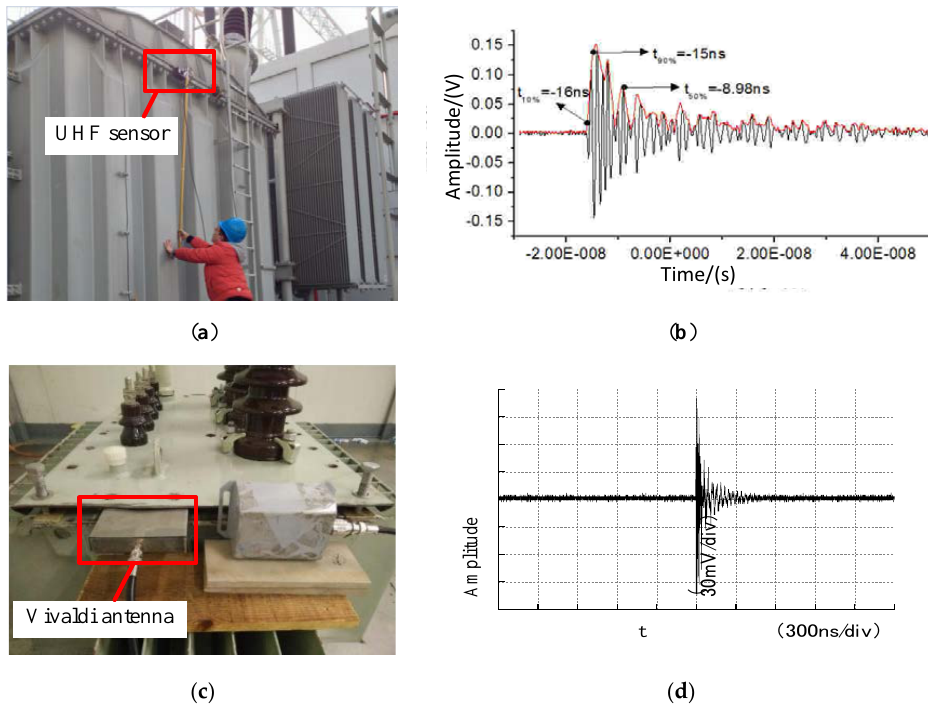
Figure 2. Gap detection of PD UHF signal in the field and in the laboratory: ( a ) Sensors installed in the gap of the high voltage reactor in the field; ( b ) Signals by UHF sensor installed in the gap of the high voltage reactor in the field; ( c ) Vivaldi antenna placed in the gap of transformer in the laboratory; ( d ) Signals by the Vivaldi antenna placed in the gap of transformer in the laboratory.